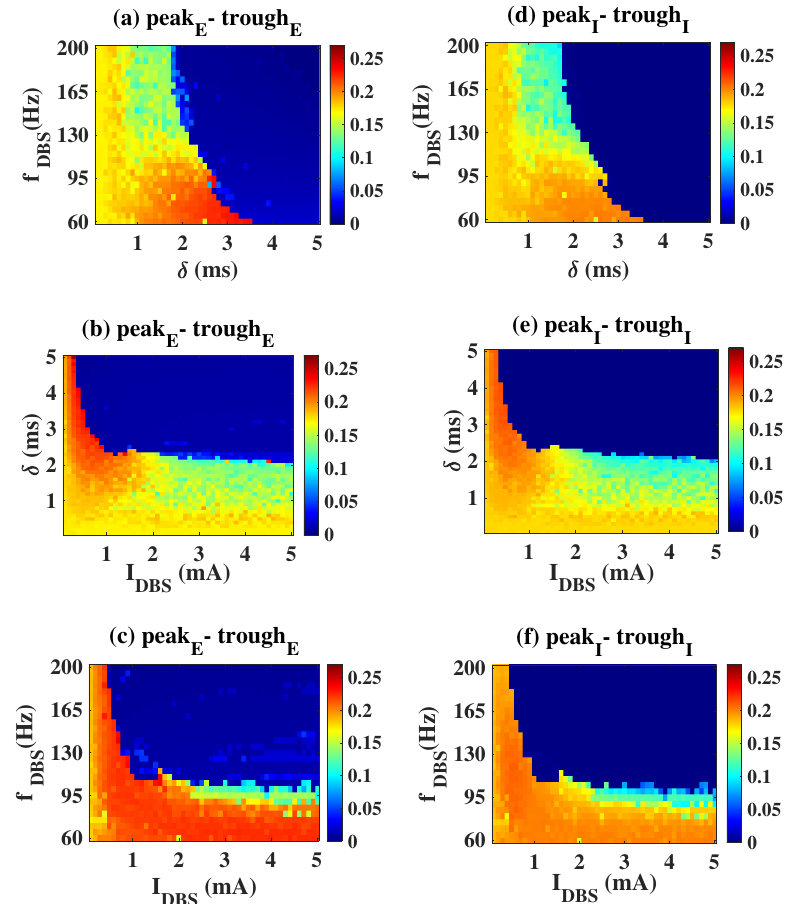
Figure 5. Evolutions of the observed indicators on the two-stimulus parameter plane. The dark blue area represents the stimulus effective area. ( a , d ): I DBS = 2 mA, ( b , e ): f DBS = 120 Hz, ( c , f ): δ = 2.5